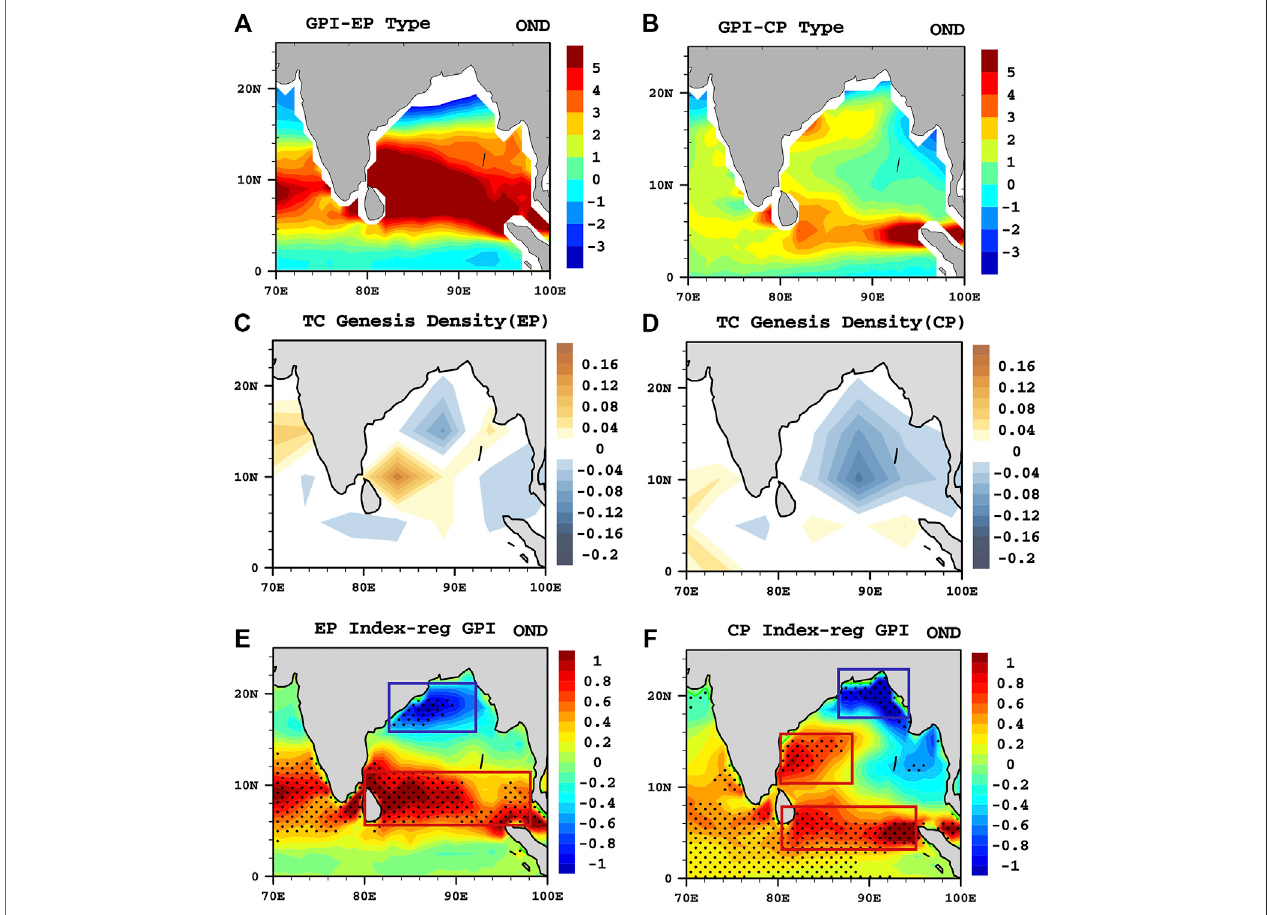
FIGURE 6 | (A) GPI anomalies during EP and (B) CP El Niño in OND. Genesis density in a 5 ° × 5 ° grid in the EP (C) and CP types (D) . (E) Spatial patterns of GPI anomaliesregressedontotheEPElNiñoIndexinONDand (F) forCPElNiñoIndex.Stipplingsindicatesigni fi cantanomaliesexceedingthe95%con fi dencelevel.Thered box indicates the GPI increase, while the blue indicates the